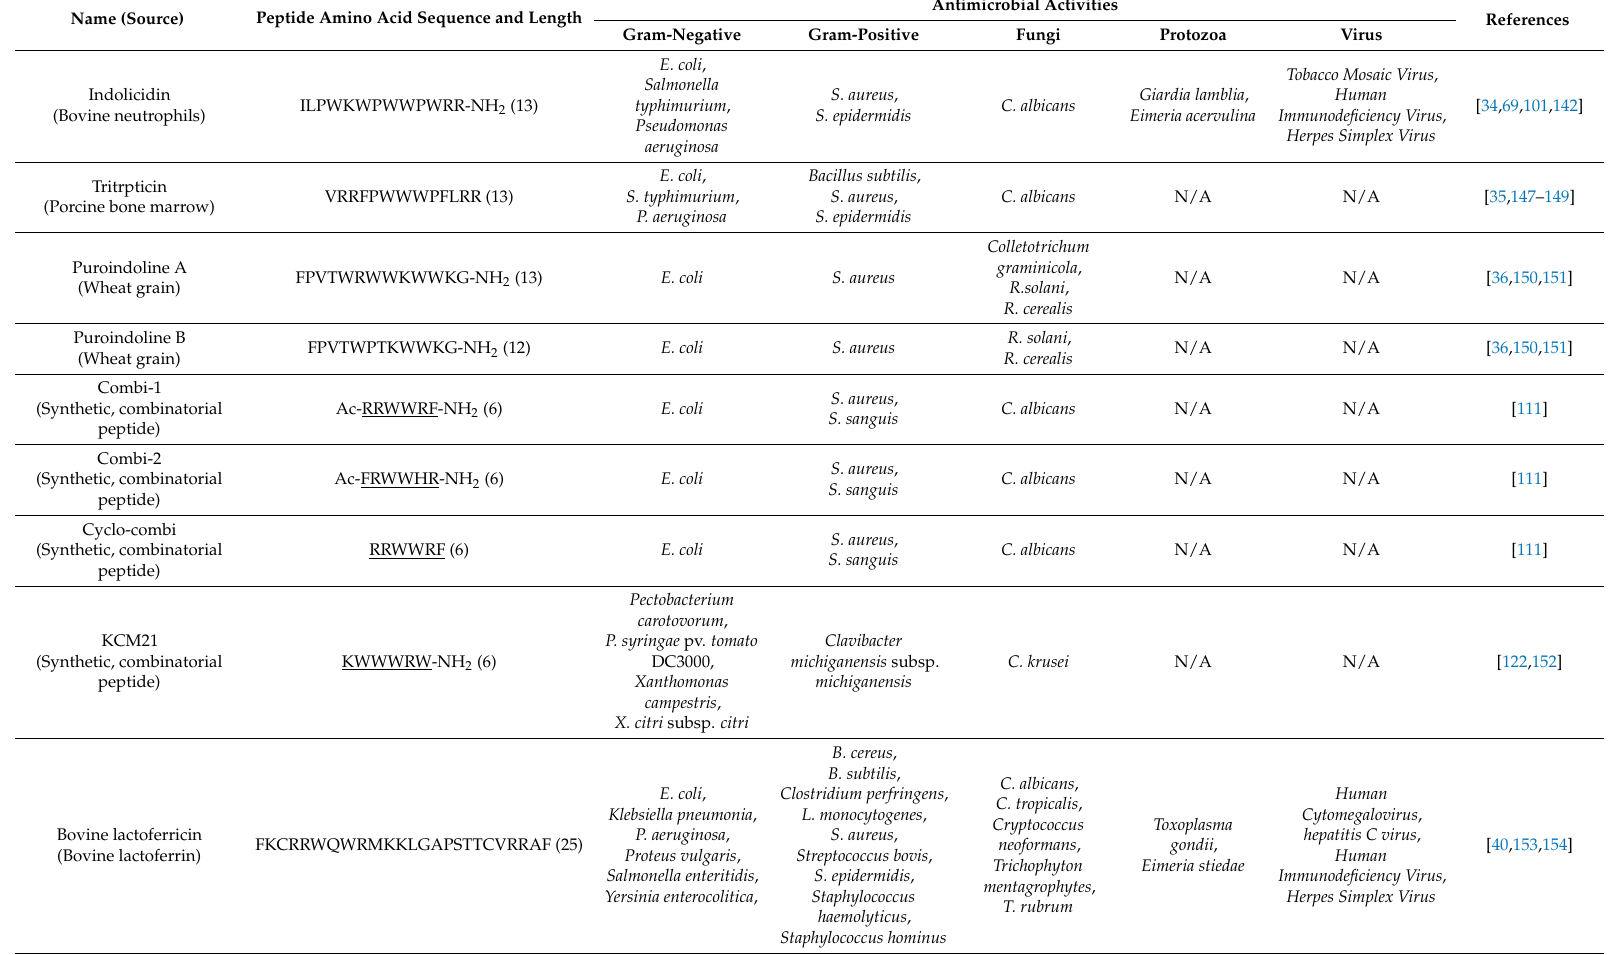
Table 2. TrAMPs and their antimicrobial activities (hexapeptide TrAMPs are in shown